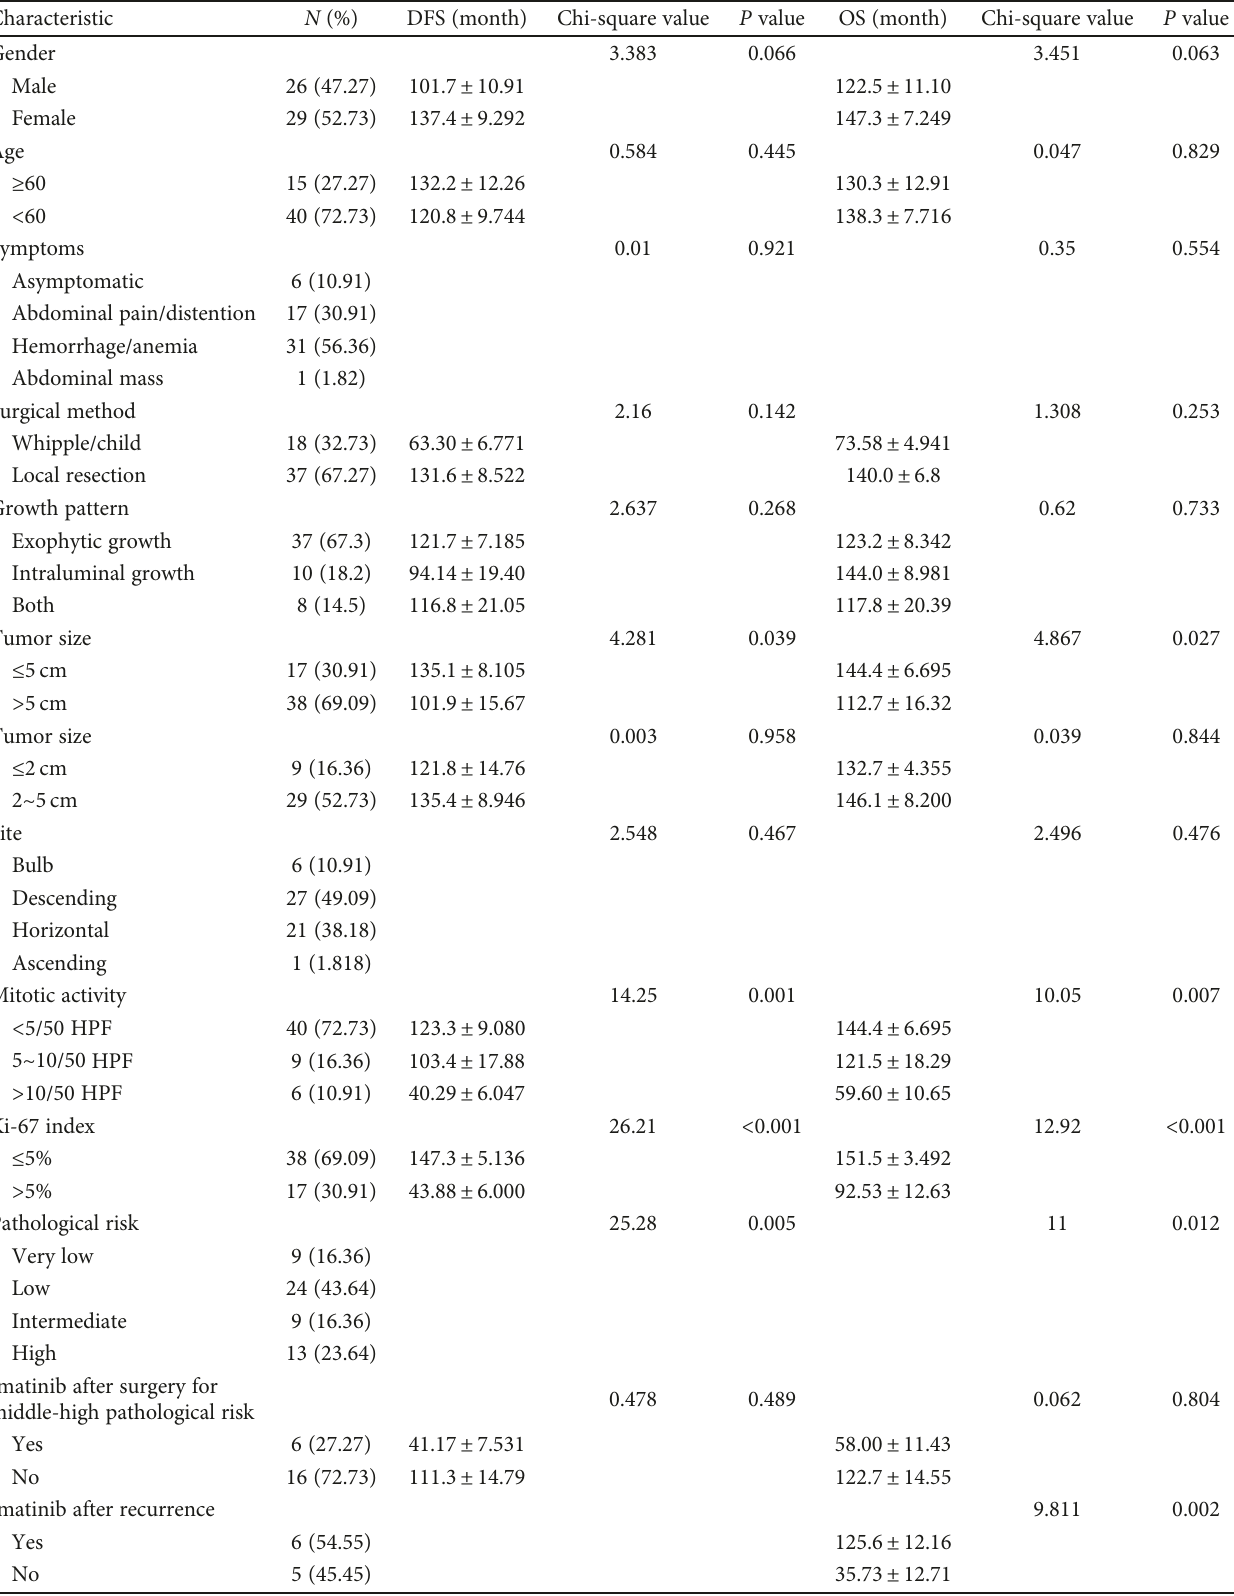
Table 1: Clinical and pathological features for 55 cases of DGIST associate with disease-free survival (DFS) and overall-survival